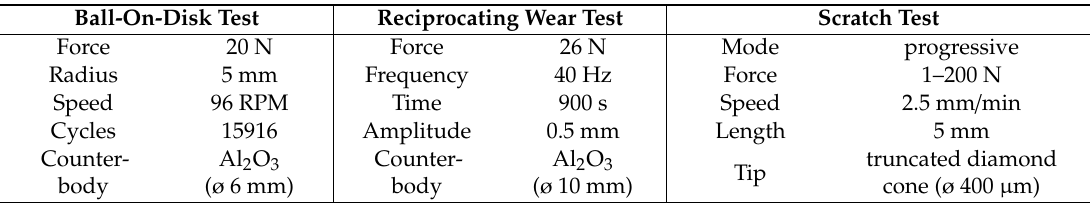
Table 3. Wear test